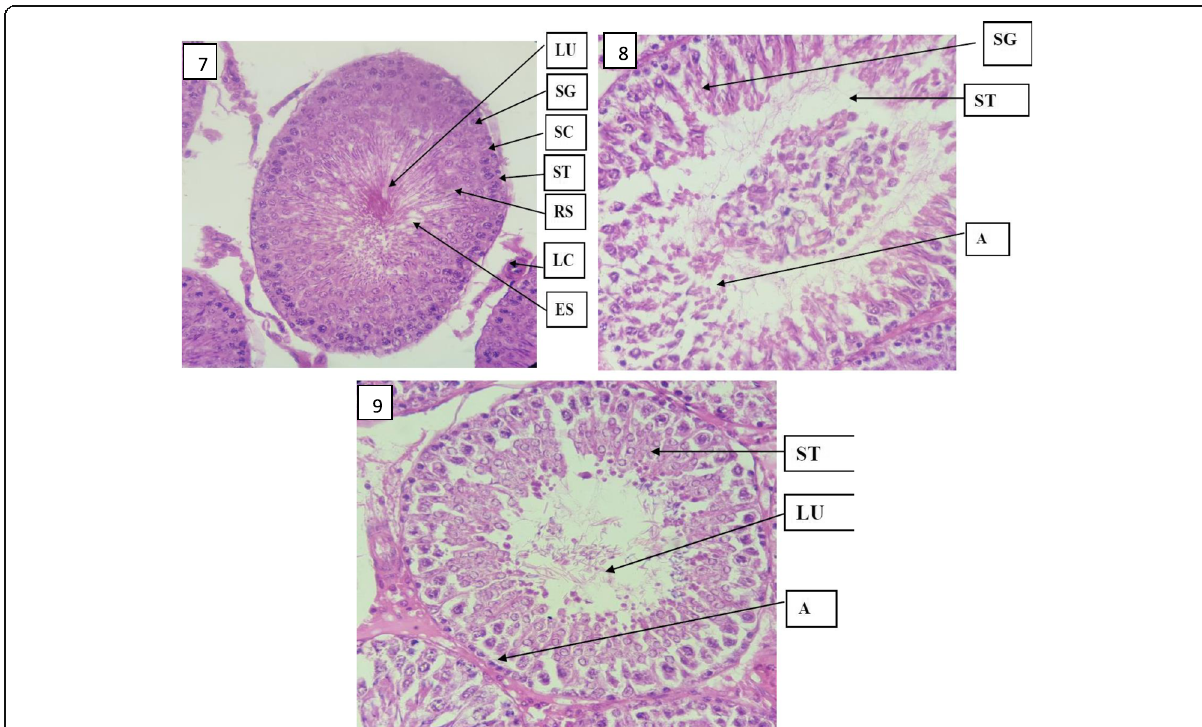
Fig. 8 Photomicrograph of histological sections of the testes of the experimental rats at week 8. H & E × 400. Plate 7: Control subgroup (1c). Interstitial cells of Leydig in the interstitial space (LC); Seminiferous tubule epithelium containing cells of the spermatogenic series including spermatogonia (SZ); spermatocyte (SC); Round spermatids (RS); elongated spermatids (ES) and sertoli cells and the lumen containing spermatozoa(LU). Plate 8: Treated subgroup (2c) with 250 mg/kg body weight of aqueous root extract of Chrysophyllum albidum. Showing, spermatogenic arrest (A) presence of immature cells in the lumen of the seminiferous tubule (ST). Plate 9: Treated subgroup (3c) with 500 mg/kg body weight of aqueous root extract of Chrysophyllum albidum. Showing, focal spermatogenic arrest (A) presence of immature cells in the lumen of the seminiferous tubule